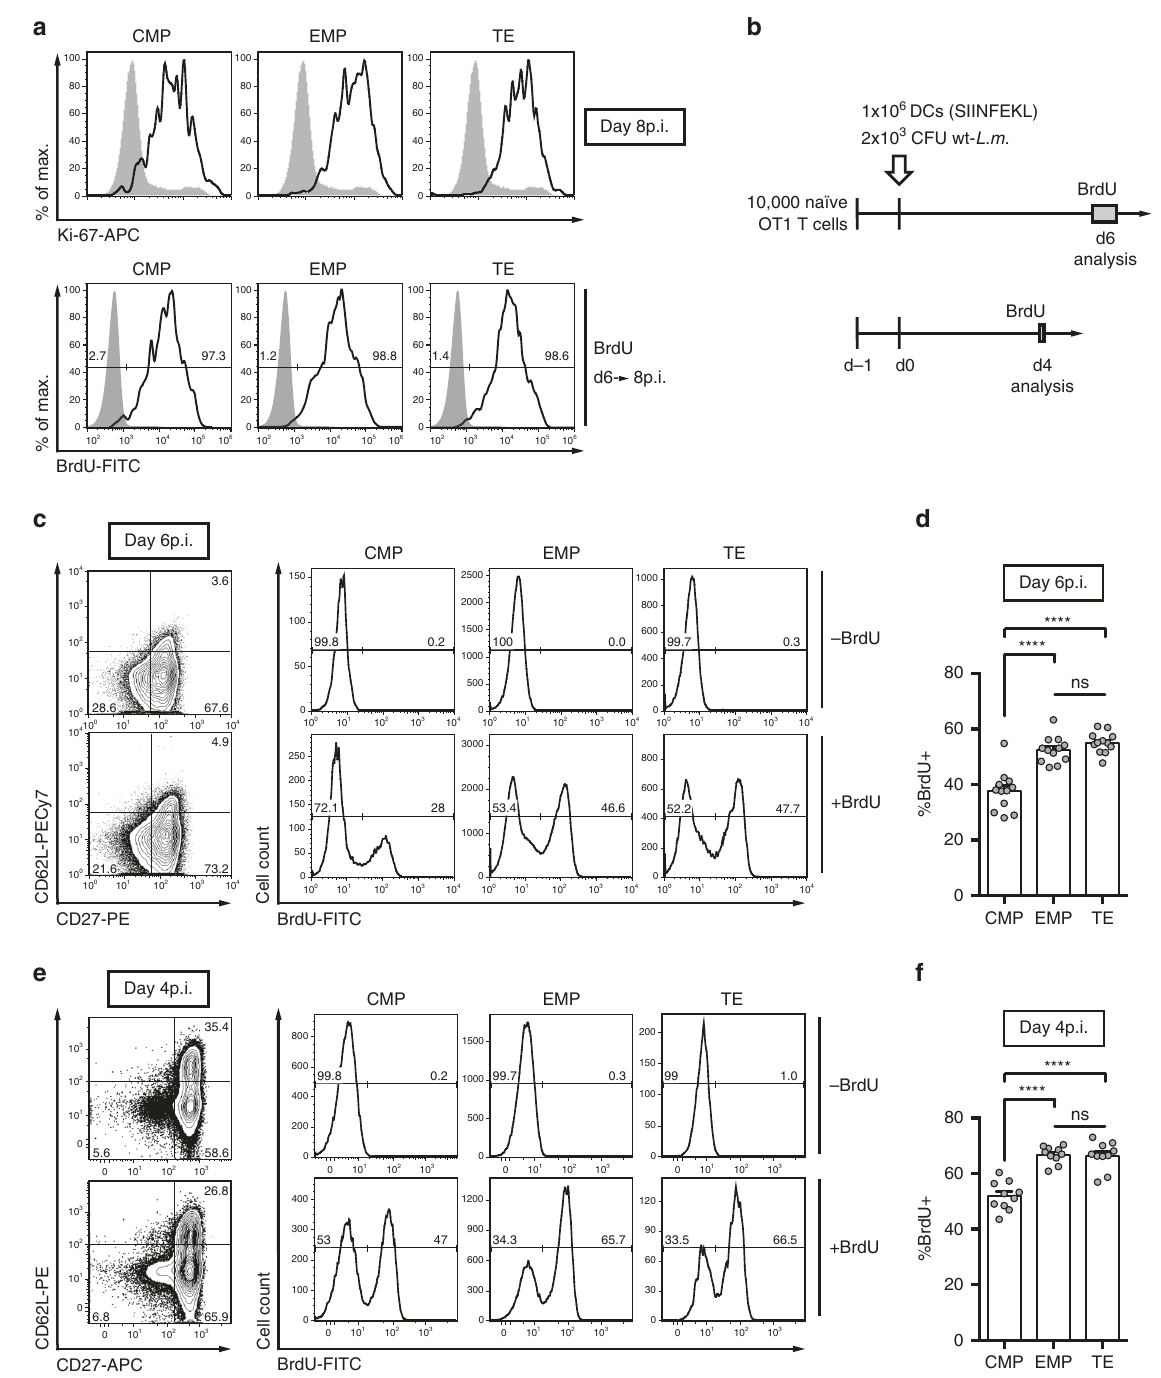
Fig. 2 Slower cell cycle speed and not premature division cessation distinguishes CMPs from EMPs and TEs. a Progenies were recovered per transferred 100 naïve OT1 cells from spleen at day 8 after DC + L.m . immunization. Representative histograms depicting expression of cell cycle-associated Ki-67 (upper row), as well as BrdU-uptake (lower row) after repetitive 6 h pulses between day 6 and 8 p.i., for CMP, EMP and TE cells (grey: endogenous naïve CD8 + T cells). b C57BL/6 mice received 10,000 naïve OT1 cells and were immunized with DC + L.m . BrdU incorporation into freshly synthesized DNA was analysed at day 6 or 4 after immunization and after 16 or 3 h of labelling, respectively. c Representative contour plots showing the expression of CD62L and CD27 for transferred T cells, with corresponding histograms showing the BrdU pro fi les of the indicated subsets at day 6 (upper row: no BrdU administered). d Bar graph depicts the percentage of BrdU + cells at day 6 ( n = 12). e , f As in c and d , but for day 4 ( n = 10). Naïve cells were excluded for the analysis (pre-gated: CD44 high ). Lines indicate the mean, error bars the s.e.m. **** P < 0.0001 (ANOVA). Data are representative of two independent experiments ( a ) or compiled from four ( c , d ) and two independent experiments ( e , f ). Source data are provided as a Source Data fi